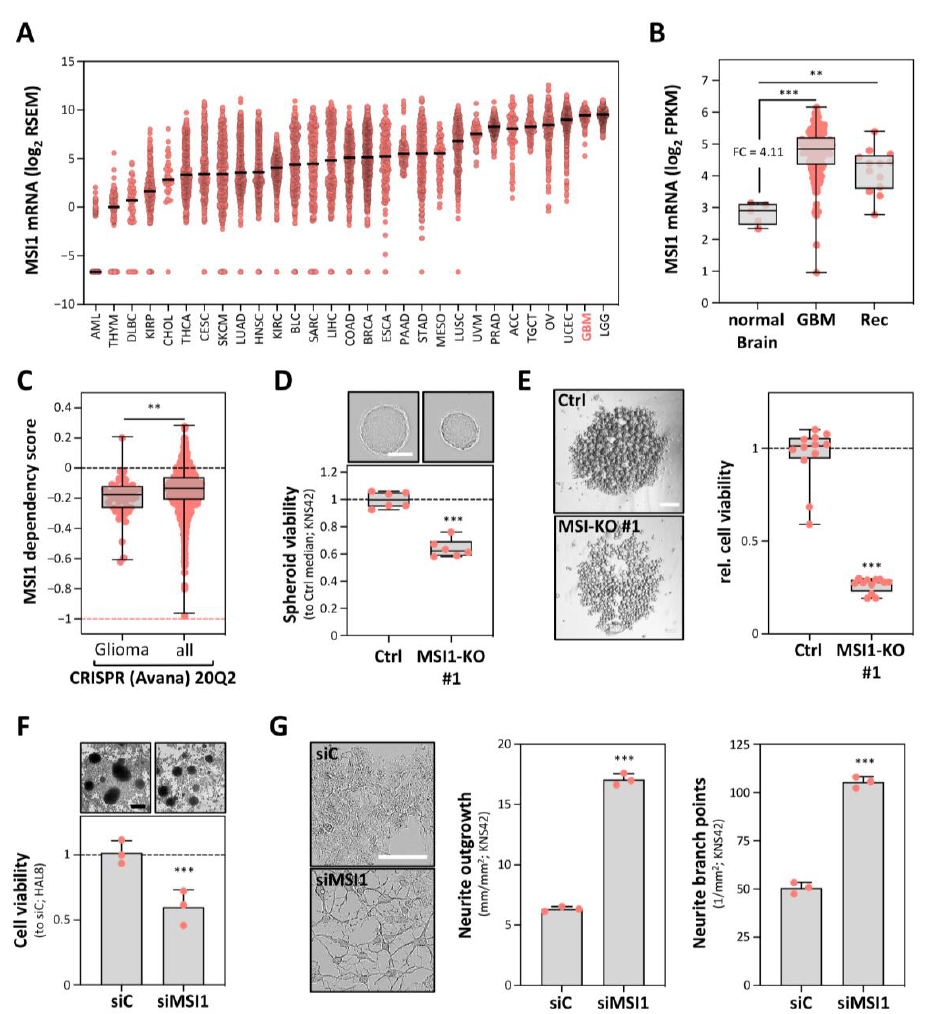
Figure 1. Musashi1 (MSI1) conveys a pro-oncogenic role in glioblastoma (GBM)-derived cells. ( A ) Scatter plot presentation of MSI1 mRNA expression in all TCGA cohorts, provided by cBioPortal. ( B ) Box plot presentation of MSI1 mRNA expression for primary GBM and paired recurrence (Rec) samples, compared to normal brain tissue, derived from TCGA. ( C ) Box plot presentation of MSI1 dependency scores, determined for glioma-derived cell lines and for all provided cell lines from the DepMap database (Avana 20Q2). Dashed line (salmon) indicates the essentiality threshold. ( D ) Spheroid viability of the Cas9-only transfected (Ctrl) and MSI1 knockout cell clones ( n = 6 per condition) as in (Figure S1B,C), determined by CellTiter-GLO, 72 h after seeding. Upper panel, representative images of the spheroids; scale bar, 150 µ m. Lower panel: box plots showing the spheroid viability normalized to the median viability of the Cas9-only transfected cell clone (set to one). ( E ) Anoikis resistance of the Cas9-only transfected (Ctrl) and MSI1 knockout cell clones ( n = 12 per condition) 7 days after seeding. Left panel, representative images of the cell aggregates; scale bar, 300 µ m. Right panel, box plots showing the cell viability as determined in (D). ( F ) Relative cell viability for the siC- and siMSI1-transfected primary tumorspheres (HAL8), determined by CellTiter-GLO, 72 h post-transfection. Upper panel, representative images of the primary tumorspheres; scale bar, 150 µ m. Lower panel, box plots showing the relative cell viability, normalized to the median of the siC-transfected cells (set to one). ( G ) Neurite growth parameters for the siC- and siMSI1-transfected KNS42 cells, 72 h post-transfection. Left panel: representative images of the KNS42 cells. Middle and right panels, quantification of the neurite outgrowth and branch points. Error bars indicate the standard deviation from at least three independent experiments. Statistical significance was determined by Mann–Whitney tests ( B , C ) and Student’s t -tests ( D – G ) (***, p ≤ 0.001; **, p ≤